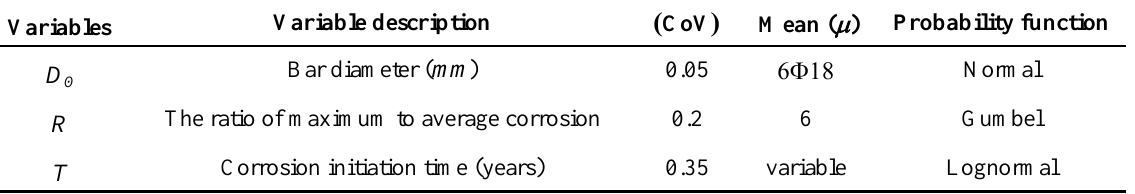
Table 4. Statistical characteristics of the basic random variables of corroded cross-sectional steel bars